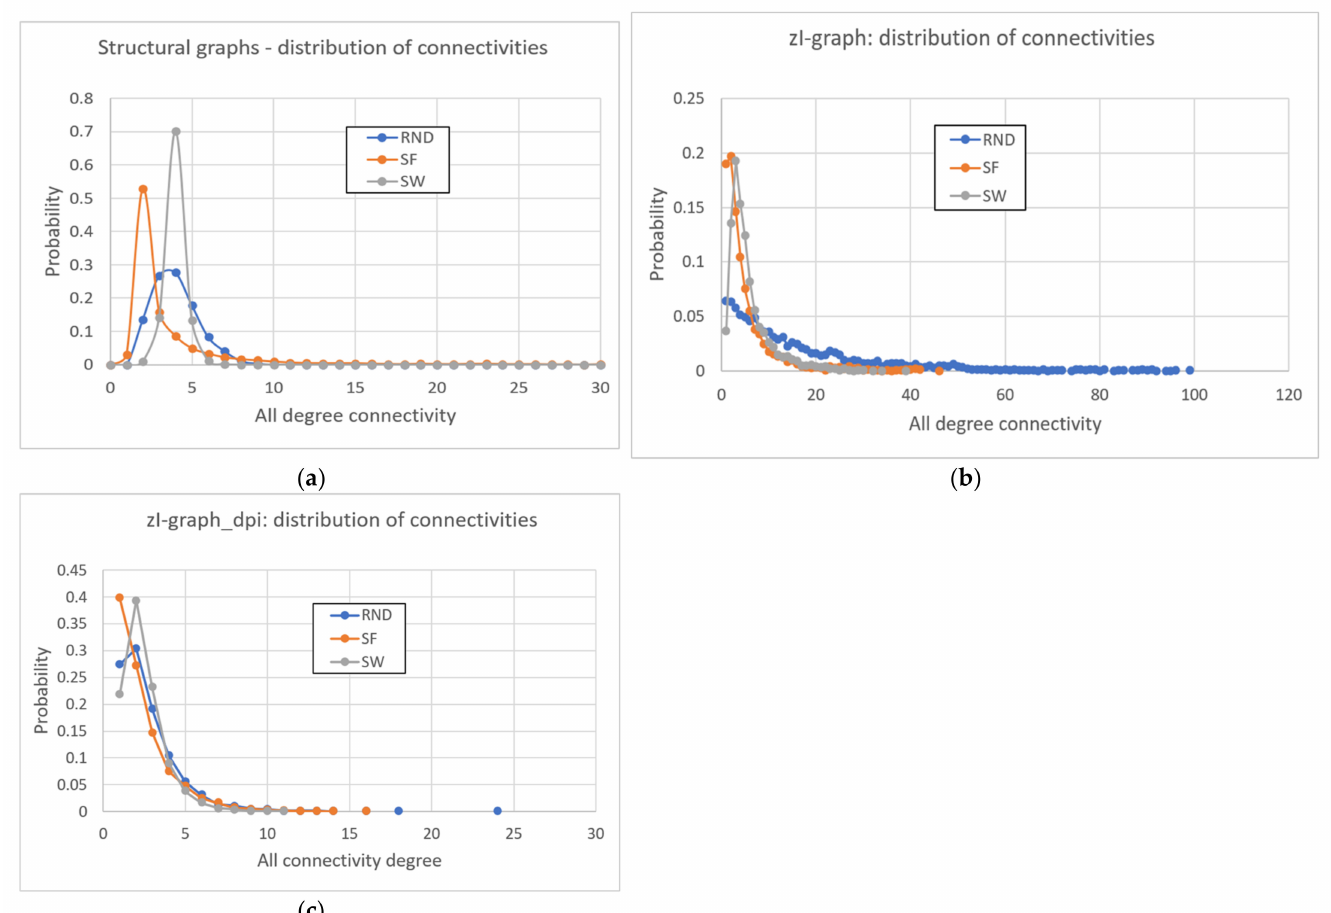
Figure A1. Characterization of the topologies of real and reconstructed networks. ( a ) Distribution of connectivity of the structural links of the three types of systems (RND, SF, and SW). ( b ) Distribution of connectivity of the zI-graph of the three types of systems. It can then be noted that the connectivity distribution of the zI-graph does not reflect the original structural distribution: in particular, in the zI-graphs there is a high number of nodes with one or two connections, while the right tail of the nodes is lengthened remarkably (in particular, the tail of RND topologies). The RND topology has a long and fat tail, while the SF and SW topologies are distinguishable thanks to the fraction of links with a single connection. ( c ) Distribution of connectivity of the zI-graph_dpi of the three types of systems. The application of DPI corrects the long tails but confirms the prominence of nodes with only one or two connections. The three topologies are distinguishable only for “rare” events (the size of maximum connectivity, showing the same order RND-SF-SW present in the zI-graph ). The fraction of nodes with only one link is not so heterogeneous as in the case of zI-graph